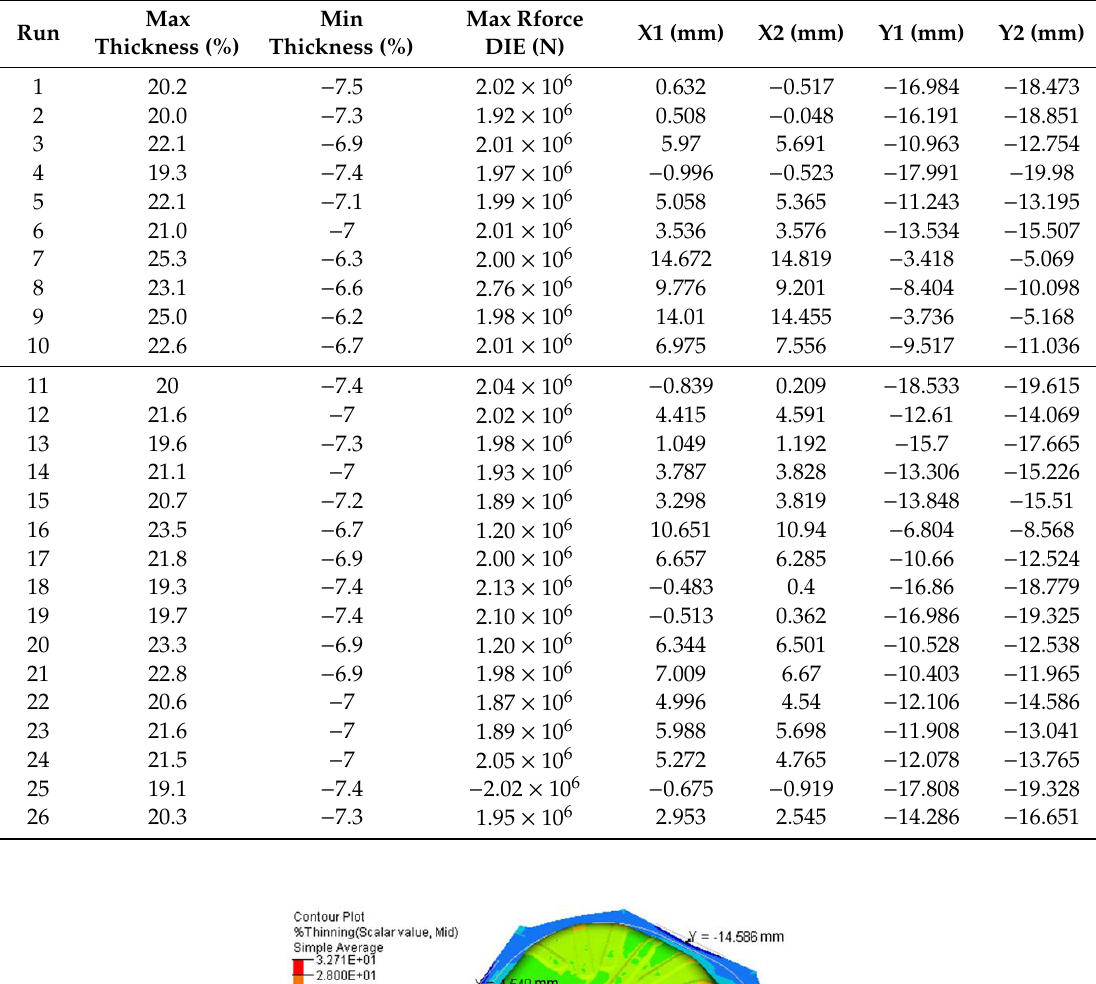
Table 4. Output of BLANK 0 simulation plan.